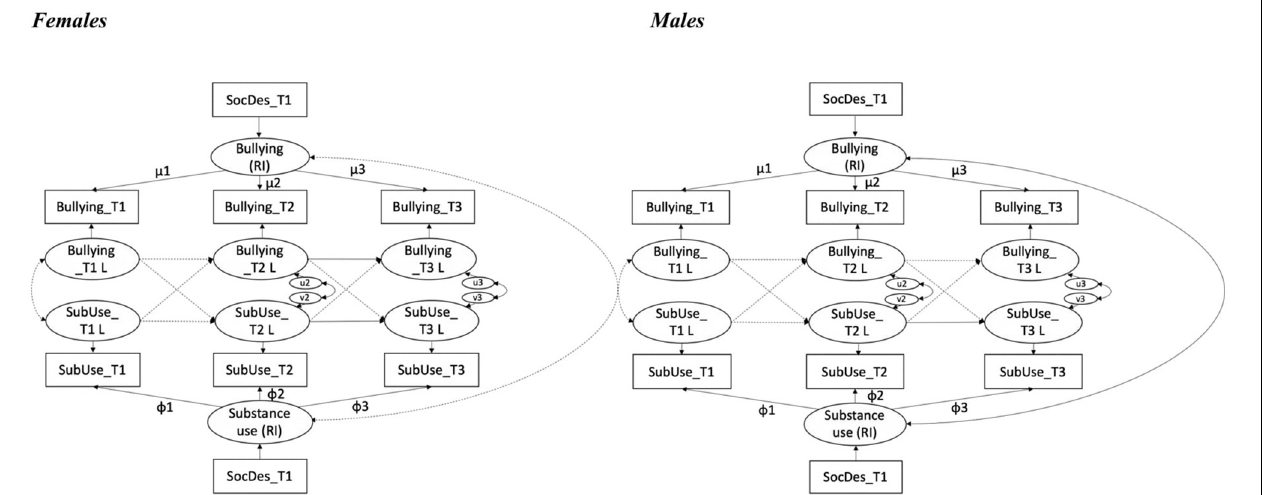
FIGURE 2 | Path diagram of the final RI-CLP Models by gender. All factor loadings are constrained to 1. RI, Random Intercept; k, Kappa; ω , Omega; µ , mu; ϕ , phi; L-suffix, Latent factor of the indicator; SubUse, Substance Use; SocDes, Social Desirability. Plain arrows indicate significant paths; dotted arrows indicate non-significant